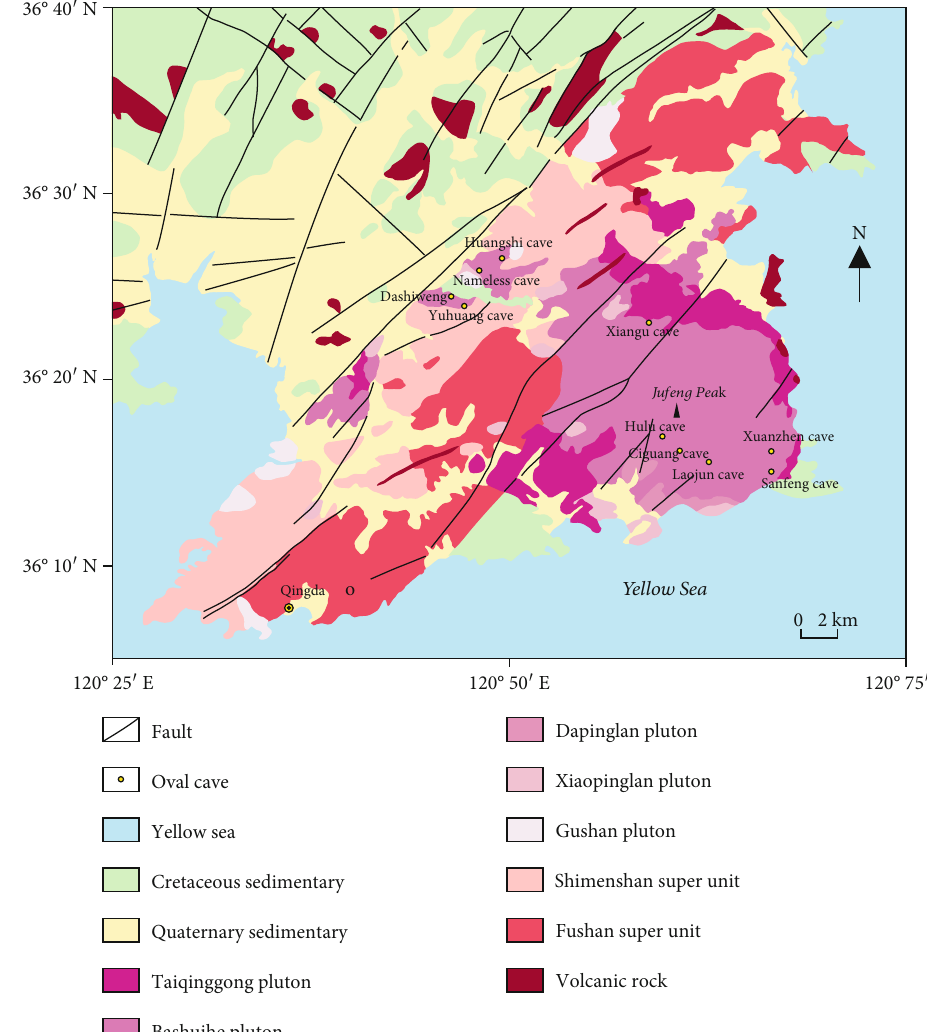
Figure 1: Regional geological map of Laoshan (modi fi ed from